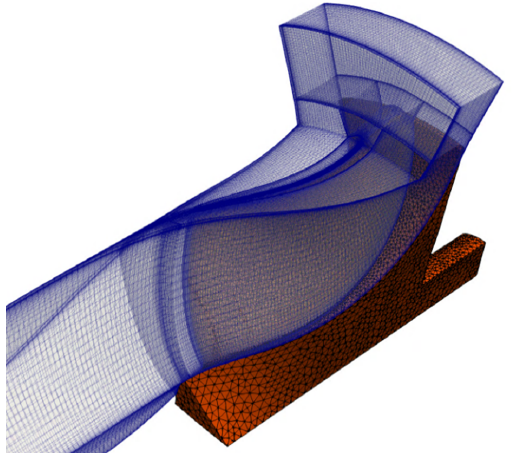
Figure 1. Radial turbine rotor: fluid and solid sector meshes.